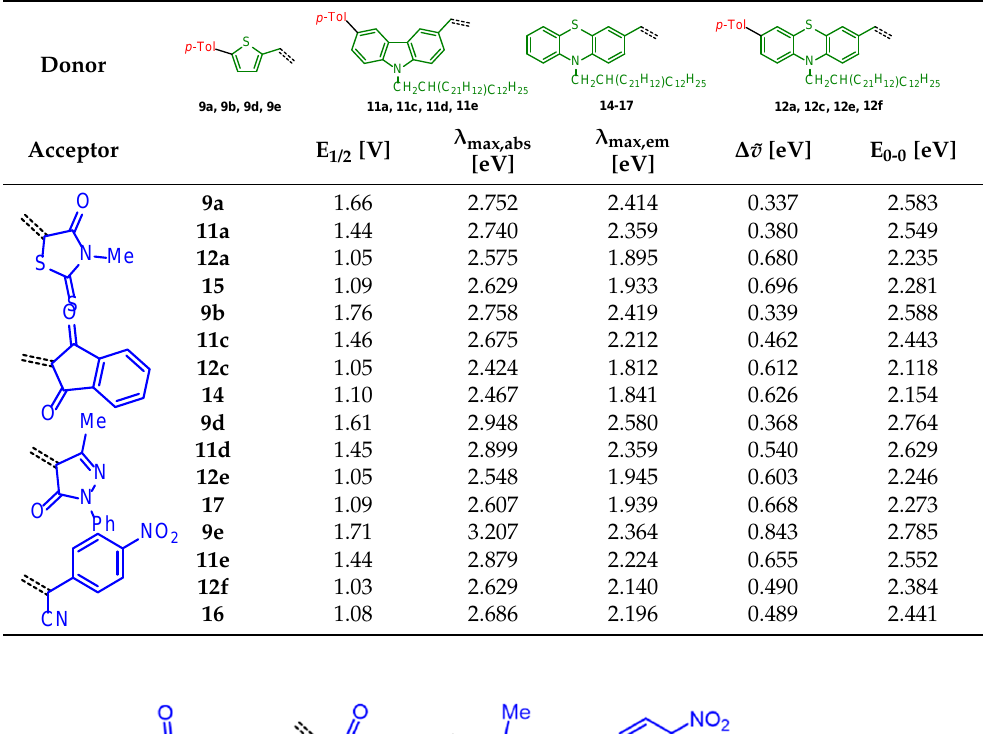
Figure 1. Comparison of four phenothiazine- N -phenyl methyl pyrazolone merocyanines with vari- able π -bridging. ( A ) Solutions of compounds 17 , 8i , 9g and 10h (from left to right) under daylight ( c = 10 −3 M ). ( B ) Normalized UV/Vis spectra of compounds 17 , 8i , 9g and 10h (recorded in dichloro- methane, c = 10 −3 M , T = 298 K). Table 2. Selected electronic properties of merocyanine series 9 , 11 , 12 , and 14 – 17 employed in the correlation analyses. Donor